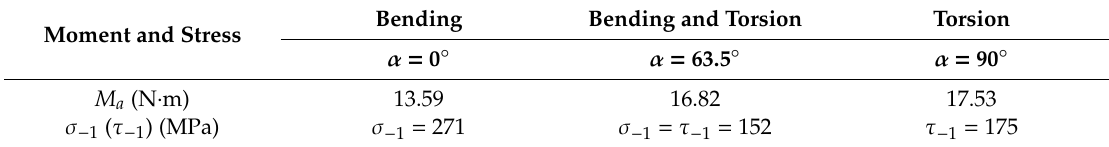
Table 4. Fatigue